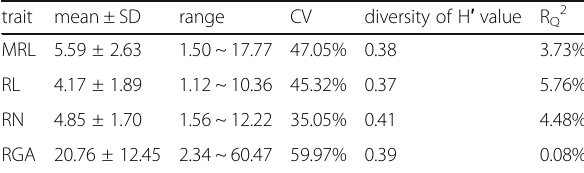
Fig. 2 Phenotypic diversity of the 145 rice accessions. a Phenotypic distribution of root-related traits in the natural population. b Correlation analysis of root-related traits. The color and area of the circle represent the value of the correlation coefficient. The number in the middle of the cell is the correlation coefficient Table 1 phenotypic variation for the root growth ability and related traits in 145 rice